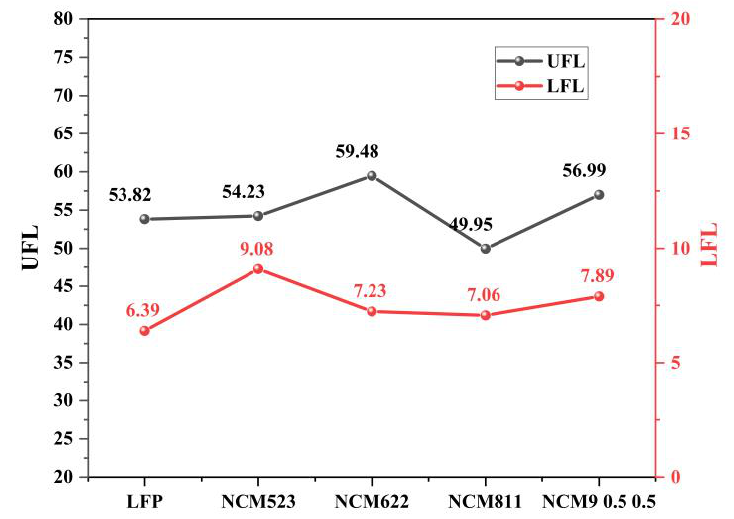
Figure 11. UFL and LFL of battery TR gas.